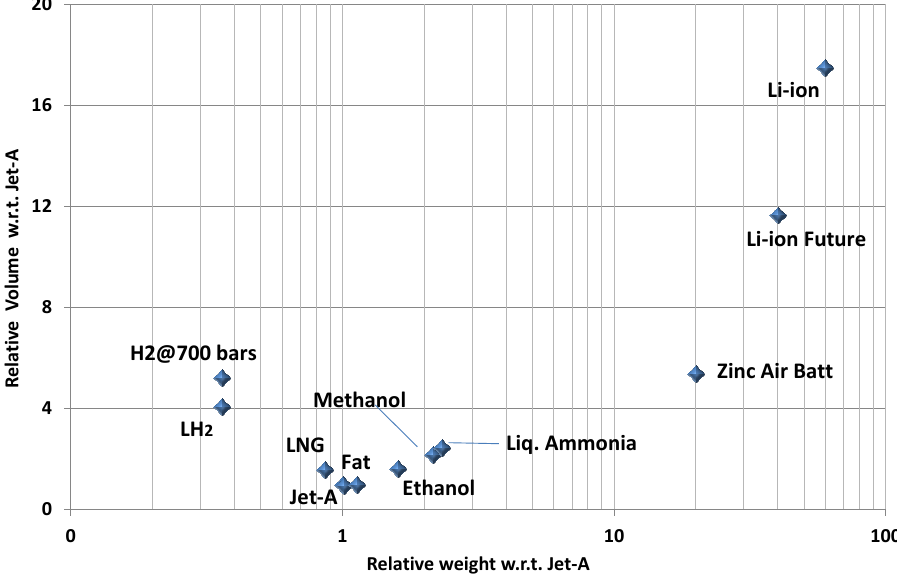
Figure 9. Comparison of various energy sources for aviation with respect to Jet-A [15]. LH 2 —cryogenic hydrogen; LNG—liquefied natural gas.